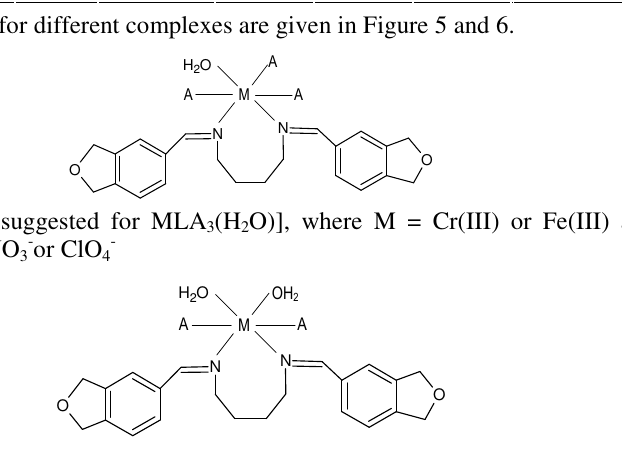
(H O) ], where M = Mn(II) and A - = CH 2 2 2